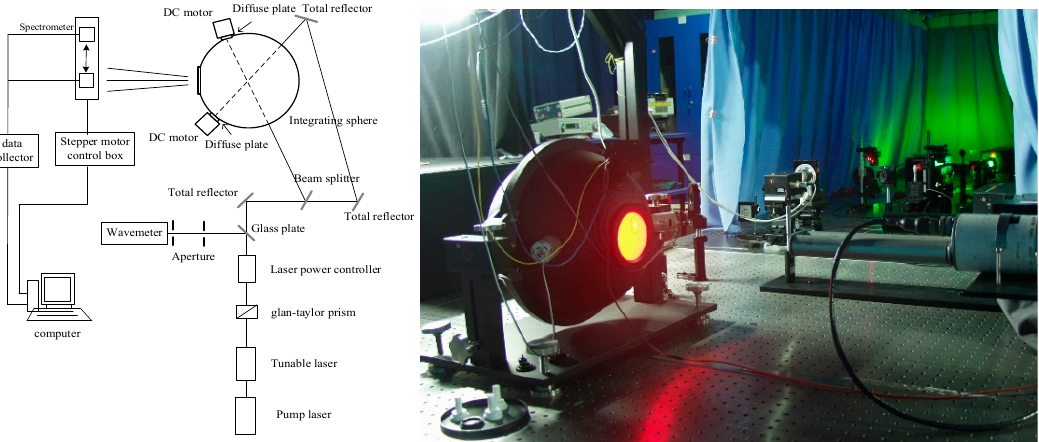
Figure 9. Tunable laser monochromatic light source (left is the layout diagram; right is the site diagram). During the test, the tunable laser and spectrometer respectively are turned on and allowed to stabilize for 20 min to the working state. The laser output wavelength is ad- justed to a certain value and the wavelength meter and power meter are used for moni- toring. After the wavelength and power are stabilized, the spectrometer collects the inter- ferogram data. Within the range of the greenhouse gas absorption spectrum (1.575 μm for CO 2 absorption band, CH 4 selection 1.650 μm absorption band) scans are performed at in- tervals of about 0.5 nm and 50 groups of monochromatic light interferogram data are col- lected at each wavelength point. The restored spectrum is normalized at the maximum sig- nal, the center wavelength of each peak after normalization is shifted to the origin of coor- dinates, and the ILS data for CO 2 (Figure 10a) and CH 4 (Figure 10b) are obtained. The in- strument spectral resolution is obtained by calculating the FWHM of ILS. The mean values of the CO 2 and CH 4 channels are 0.255 cm − 1 and 0.265 cm − 1 , respectively, which meet the requirements of satellite payload resolution.